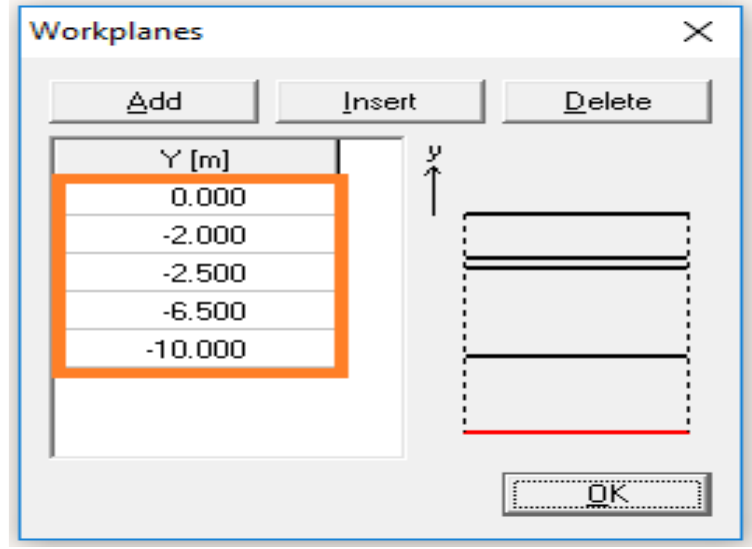
Fig. 4. Workplanes